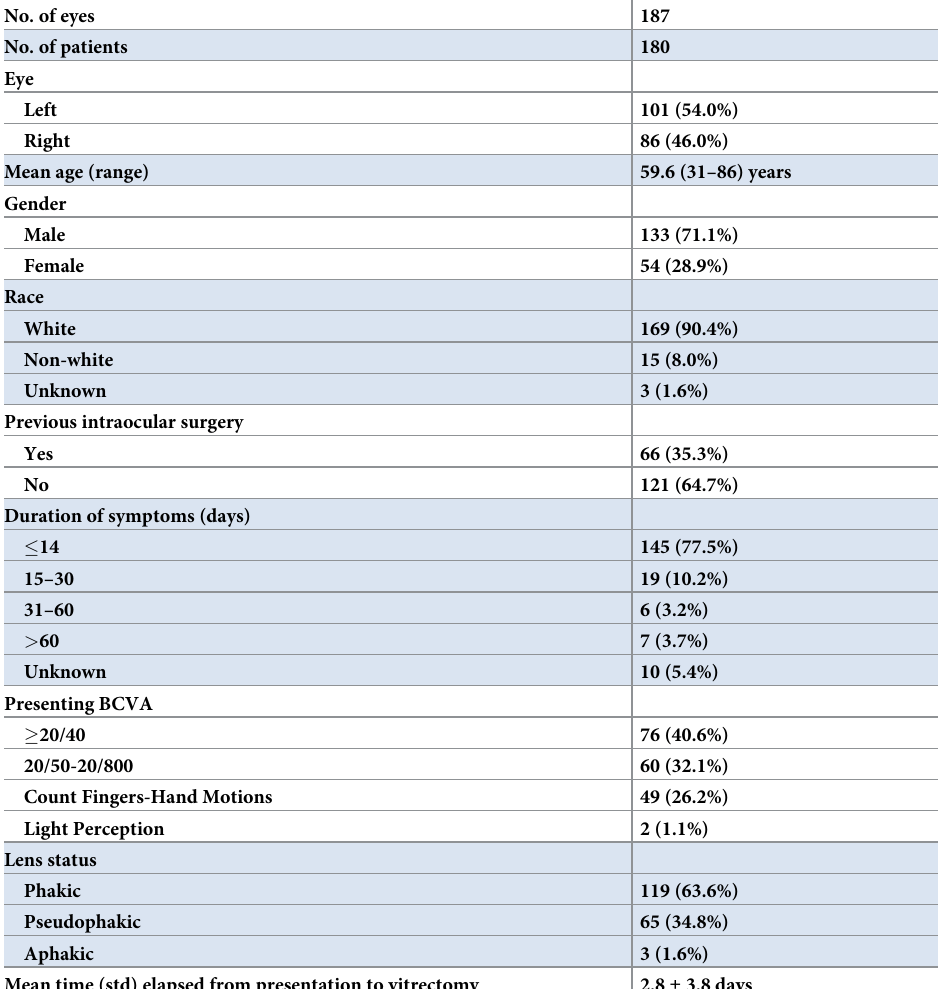
Table 1. Baseline